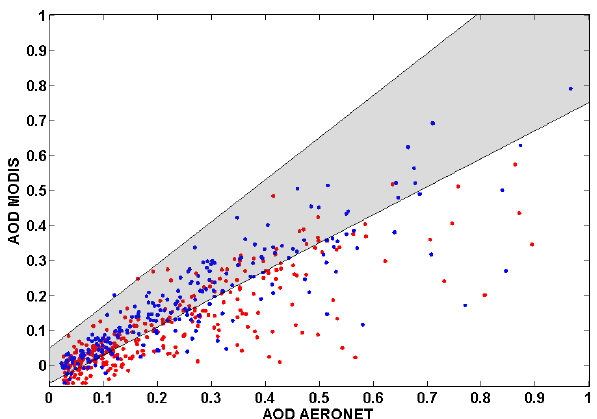
Fig. 4: Comparison of AOD values between June 2006 and November 2008 retrieved from Fig. 4. Comparison of AOD values between June 2006 and Novem- MODIS-Terra (249 red dots) and Aqua (210 blue dots) instruments at 550 nm, and Ispra ber 2008 retrieved from MODIS-Terra (249 red dots) and Aqua AERONET sun-photometer. The sunphotometer-derived AOD  MO at 550 nm have been (210 blue dots) instruments at 550nm, and Ispra AERONET sun- calculated using the Angström exponent between 500 and 675 nm. The gray shaded area photometer. The sunphotometer-derived AOD τ MO at 550nm have represents the standard deviation  MO = ±0.05±0.2  MO on MODIS radiometers. been calculated using the Angstr¨om exponent between 500 and 675nm. The gray shaded area represents the standard deviation σ MO =± 0.05 ± 0.2 τ MO on MODIS radiometers.